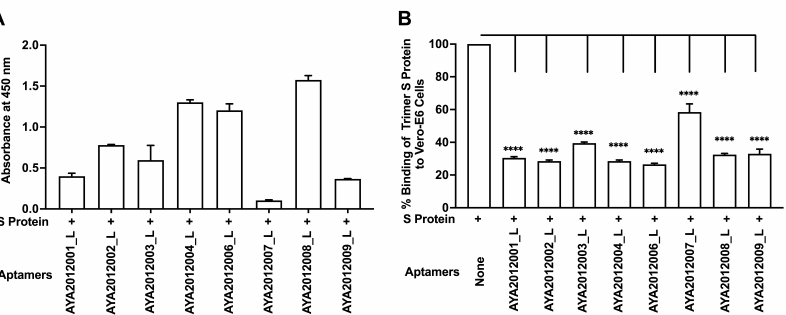
Figure 5. Characterization of selected aptamers containing primer sequences (long aptamers). ( A ) ELISA-based binding assay of the selected aptamers containing primer sequences (long ap- tamers). SARS-CoV-2 trimer S protein was immobilized on a MaxiSorp plate and biotinylated aptamers were added at 10 nM concentration for 1 h incubation with the protein. Bound aptamers were detected using streptavidin–HRP. ( B ) Cell-based binding assay of SARS-CoV-2 trimer S protein to ACE2 expressing Vero E6 cells in the absence or presence of the selected aptamers containing primer sequences (long aptamers). His-tagged SARS-CoV-2 trimer S protein at 10 nM was added to Vero E6 cells after pre-incubation with 5 µ M of indicated aptamer. After 1 h incubation, the unbound trimer S protein was washed out, and the cell pellet was solubilized with 1% Triton X100. The supernatant-containing solubilized trimer S protein was applied to a nickel-coated plate. His-tagged trimer S protein bound to nickel was detected using mouse monoclonal antibodies against S protein and horseradish peroxidase-conjugated goat anti-mouse antibodies. Each value was the average of duplicate measurements. Error bars represent mean ± SD ( σ ). p -value were determined with one-way ANOVA, Dunnett’s multiple comparison test. **** denotes p <